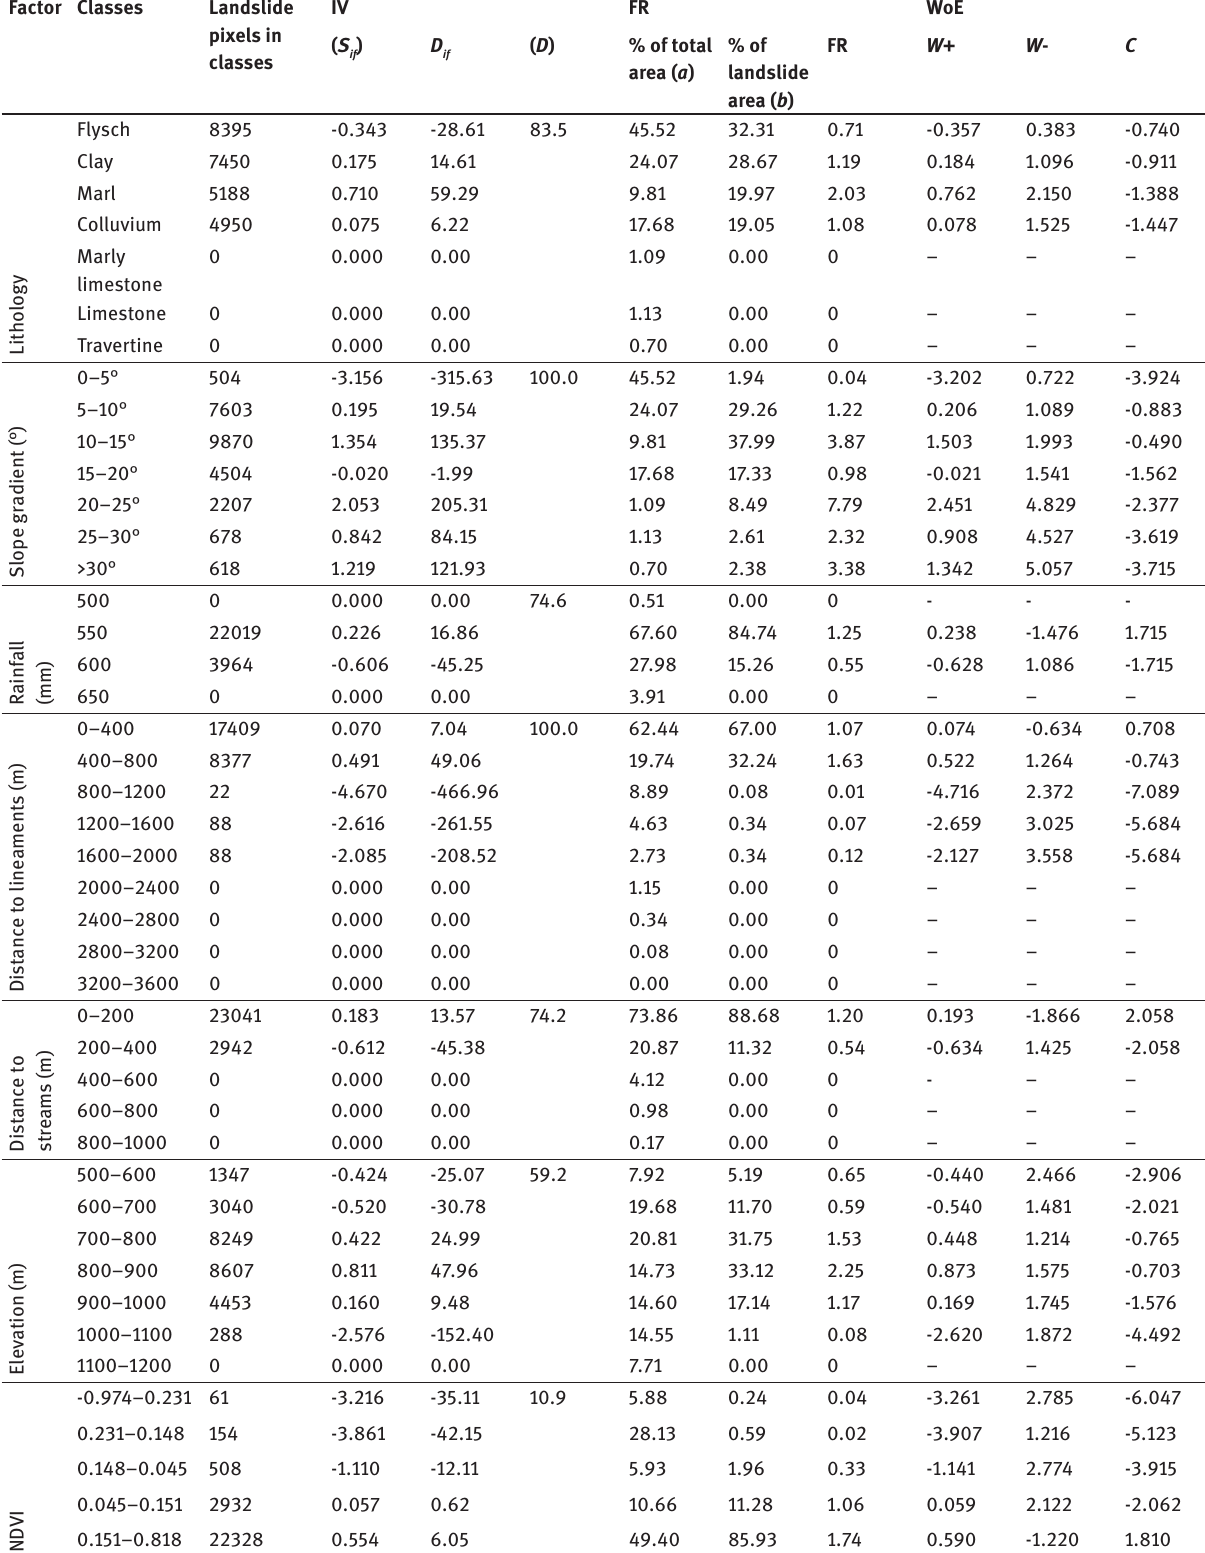
Table 1: Spatial relationship between landslide and conditioning factors in the study. Factor